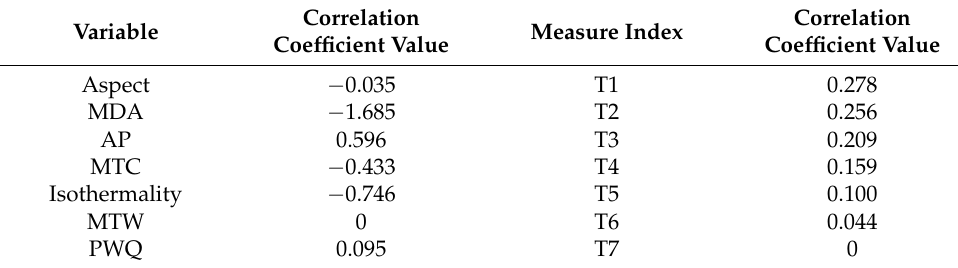
Table 3. CSHRR model parameters of Dongting Lake Basin.